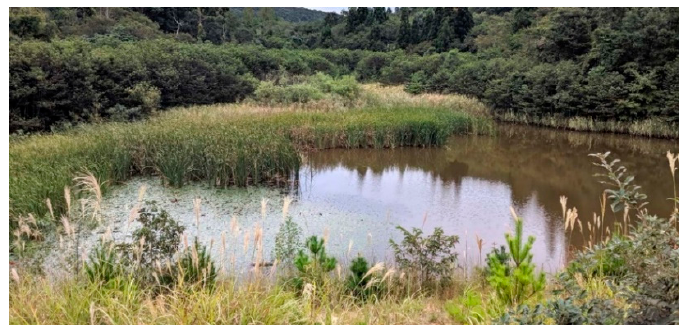
Figure 2. Acheilignathus typus collected from an irrigation pond in northern Niigata prefecture.